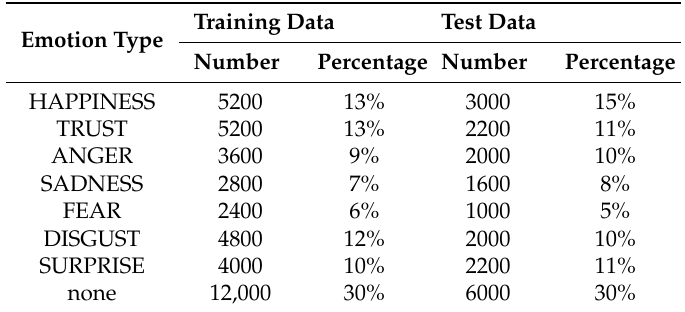
Table 1. Examples of the emotional vocabulary ontology format.